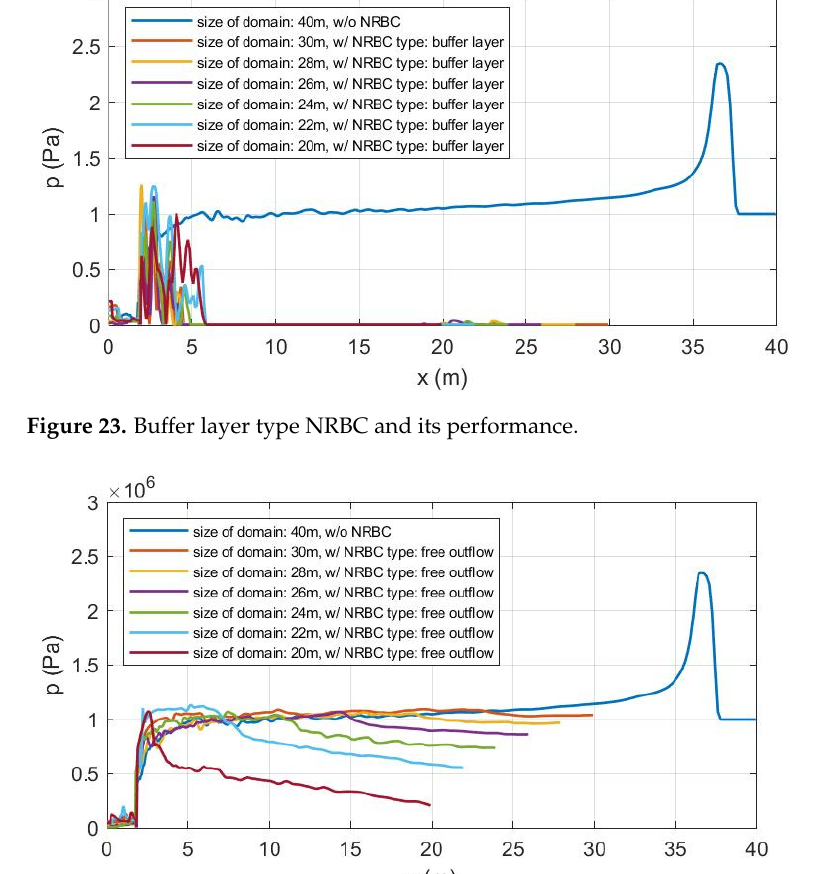
Figure 25. Cell stencil at the boundary.